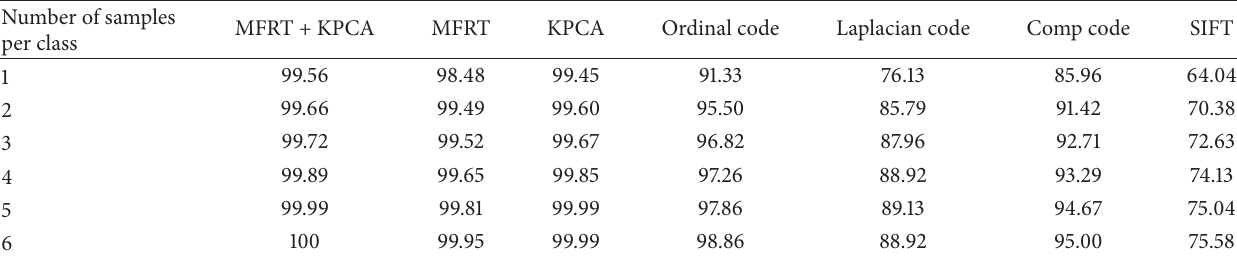
Table 5: Accuracy measures from Poly U right hand multispectral palm print image.